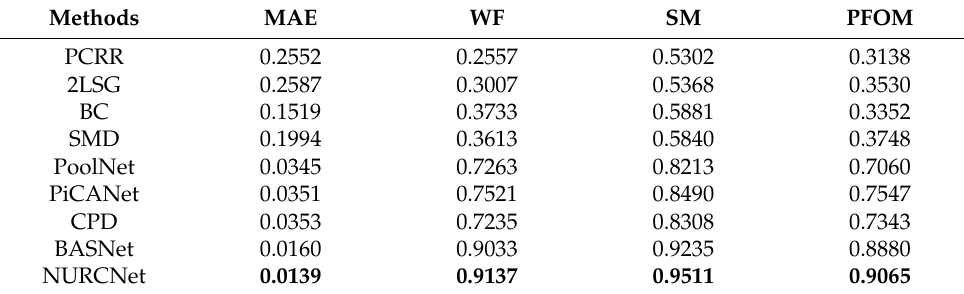
Table 3. Comparison of results from nine competitive methods.